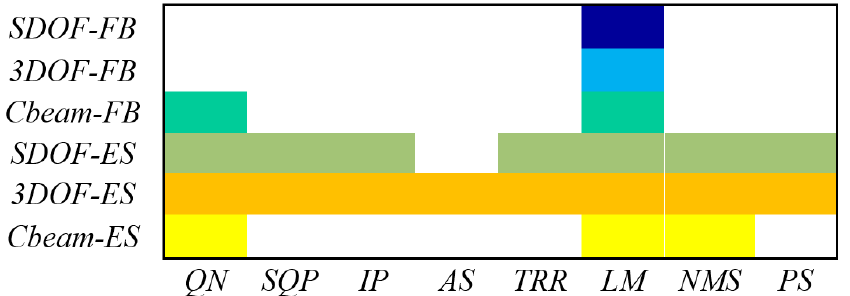
Figure 7. Delivering the true nonlinear model for each benchmark. Color tiles: successful; white tiles: unsuccessful at delivering the true model.